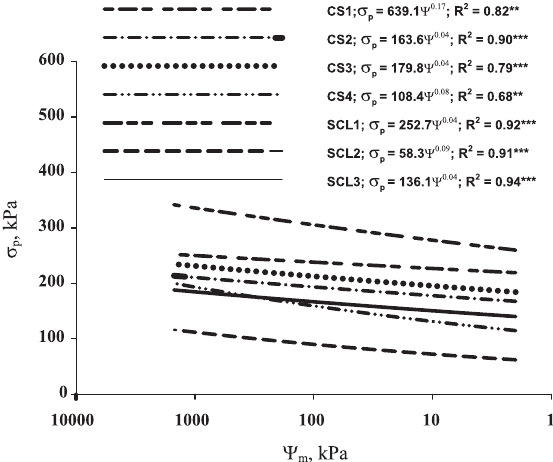
soils.Figure 6. Preconsolidation pressure at varying water